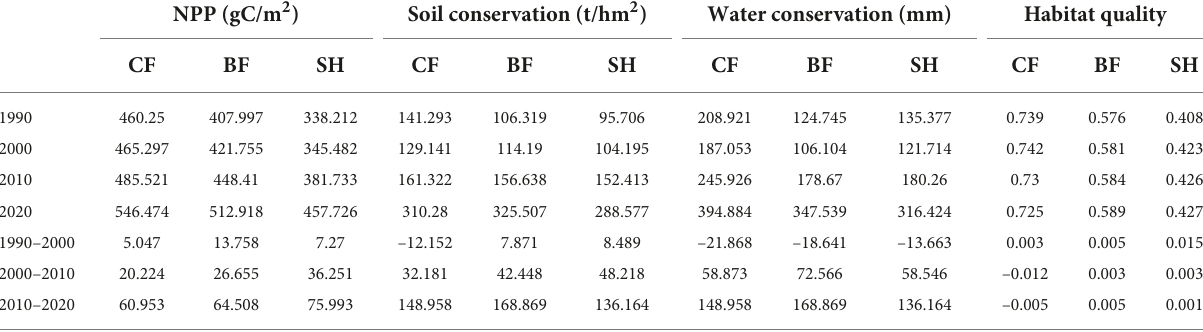
TABLE 2 Temporal changes of forest ecosystem services in the Greater Khingan Mountains from 1990 to